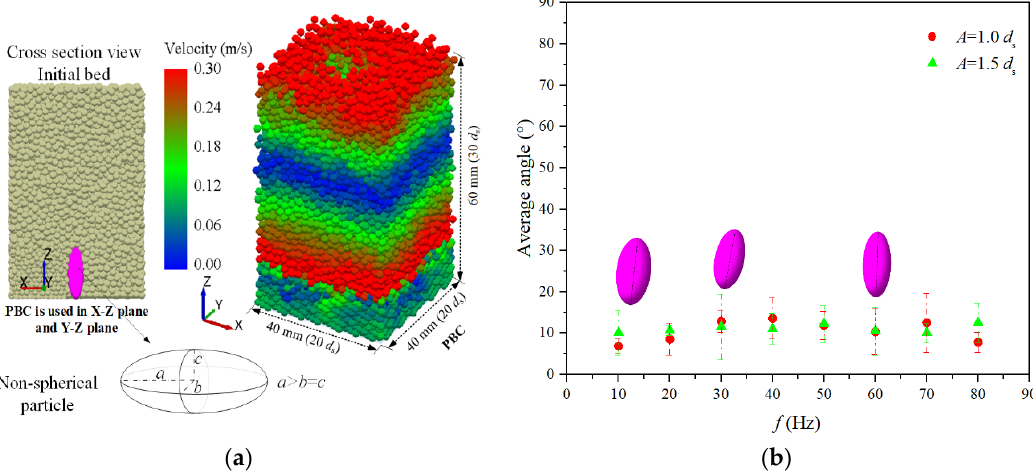
Figure 1. ( a ) Schematic of the simulated single non-spherical intruder in a vibrated bed of small particles; ( b ) average angle between the intruder’s long axis and the vibration direction—the error bar shows the variation range of the acute angle between the intruder’s long axis and the Z-axis.